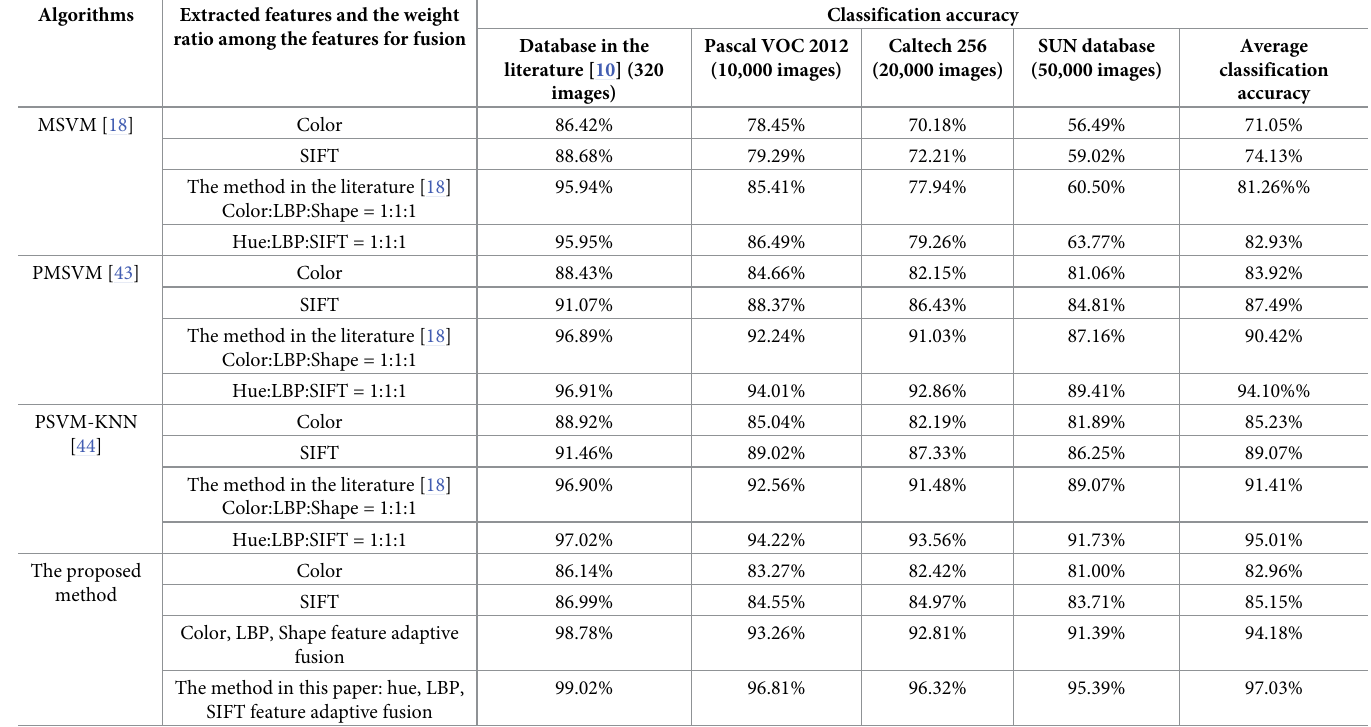
Table 1. Comparison of the classification accuracies of different algorithms and different feature fusion methods. Algorithms Extracted features and the weight ratio among the features for fusion